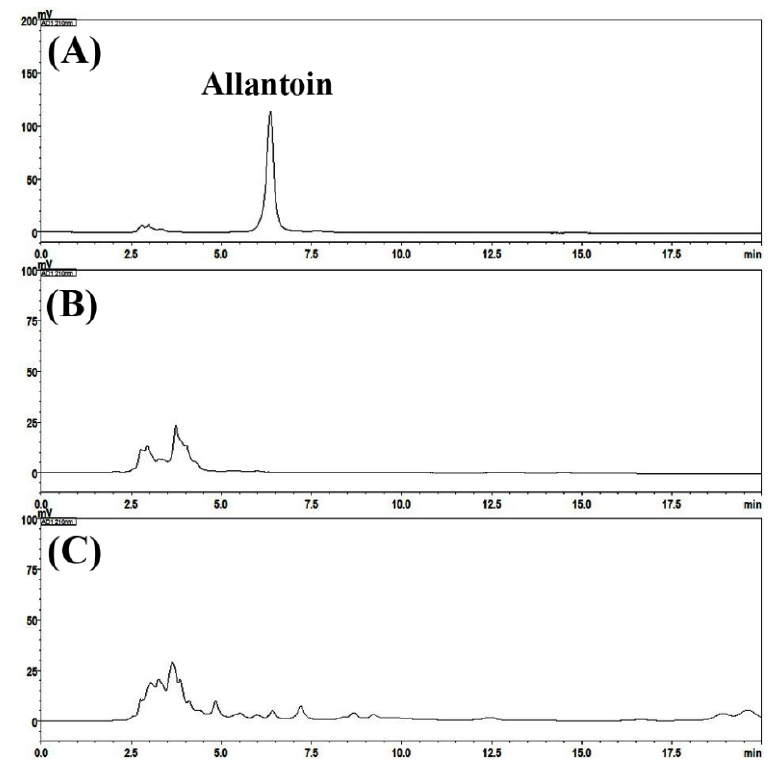
Figure 2. Representative HPLC-PDA chromatograms of the reference compound ( A ), placebo ( B ) and Samryeongbaekchulsan sample ( C ) at 210 nm.